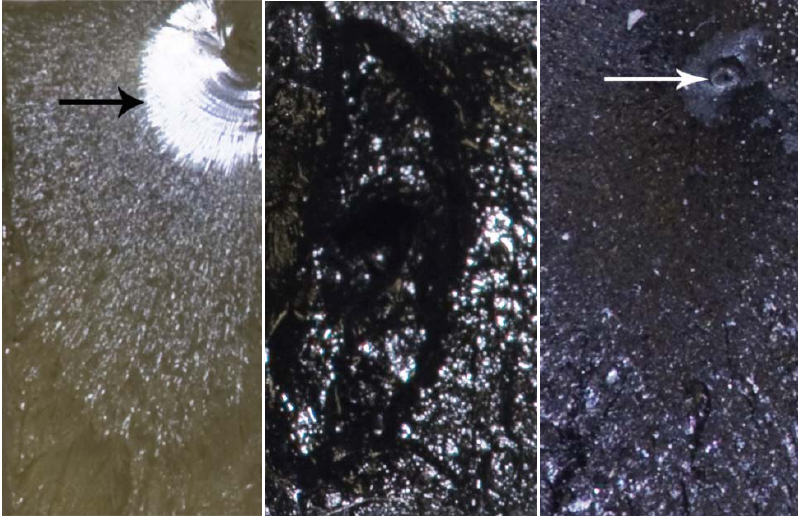
Figure 6. Digital photograph of fractured cross sections of pure epoxy ( right ), epoxy composite reinforced by untreated 10–30 nm diameter MWCNTs ( middle ), and epoxy composite reinforced by plasma treated 10–30 nm diameter MWCNTs ( left ). The arrows point to the mirror zone induced by fracture.